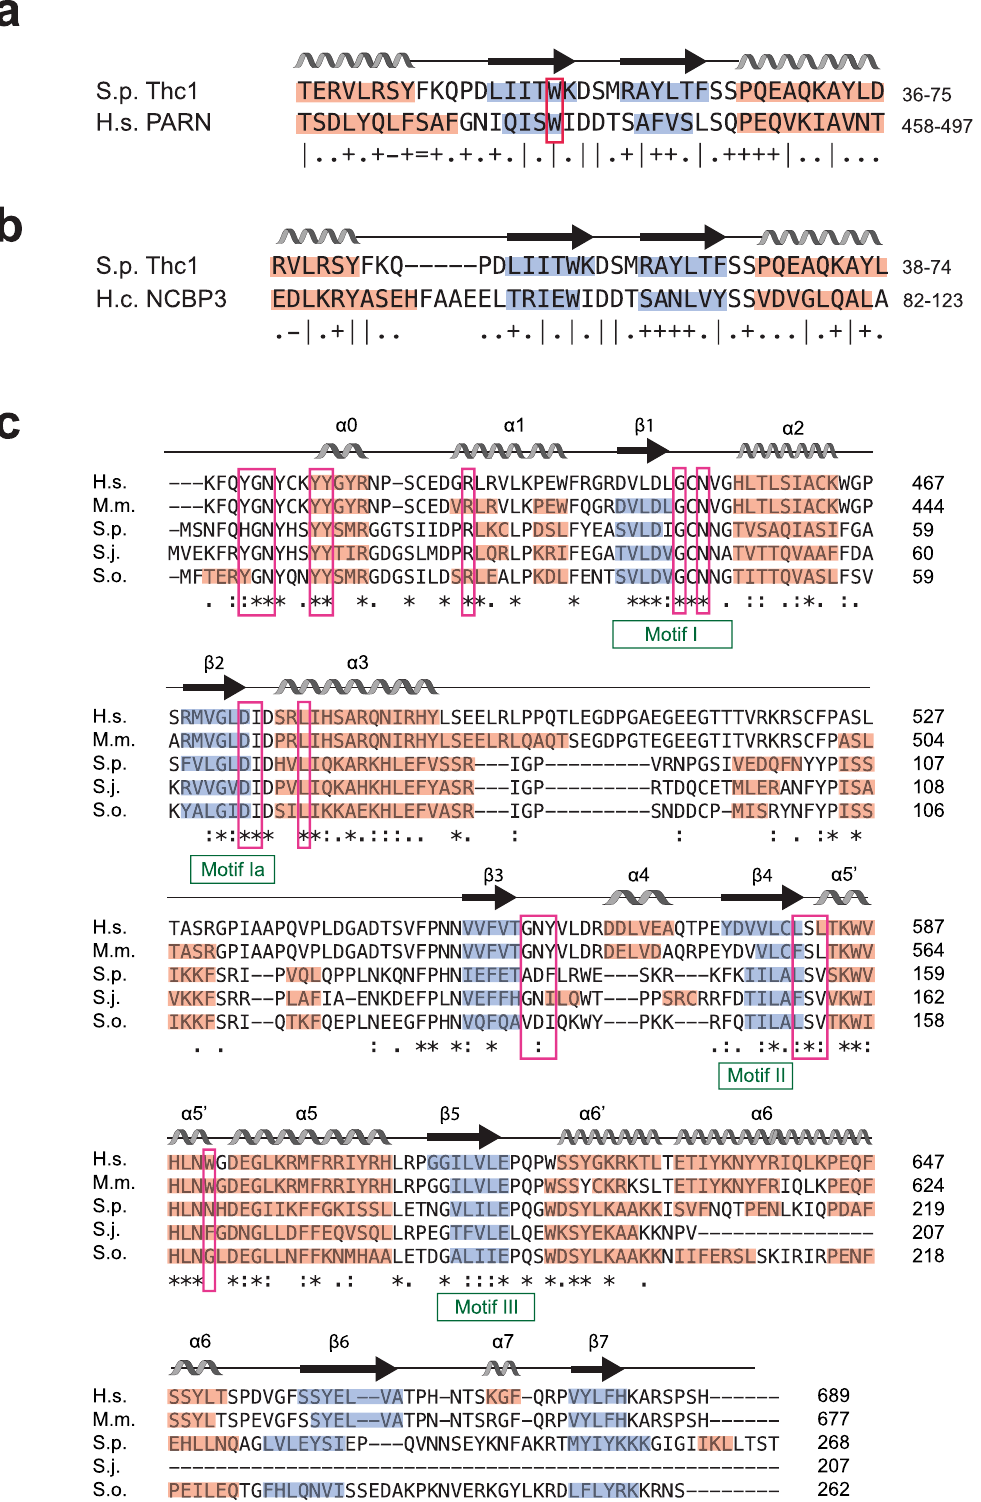
Bmc1 function in telomerase biogenesis is independent of its catalytic activity . As vertebrate MePCE and Drosophila Bin3 bind the 5 ′ triphosphate caps on 7SK and U6 snRNA and function enzymatically by transferring a methyl group onto the γ -phos- phate, it is not apparent how TER1 with its trimethylguanosine cap could be targeted by Bmc1. Nevertheless, sequence